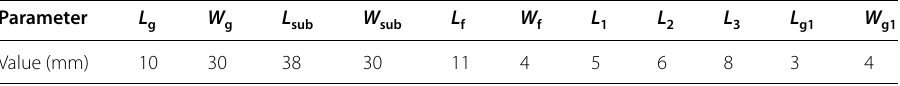
Table 1 Proposed antenna design parameters